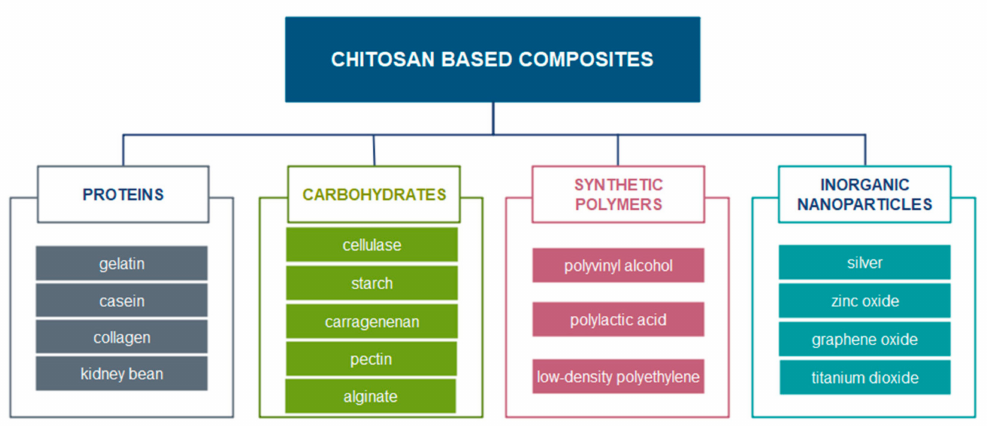
Figure 9. Materials for chitosan-derived composites processing for food packaging application